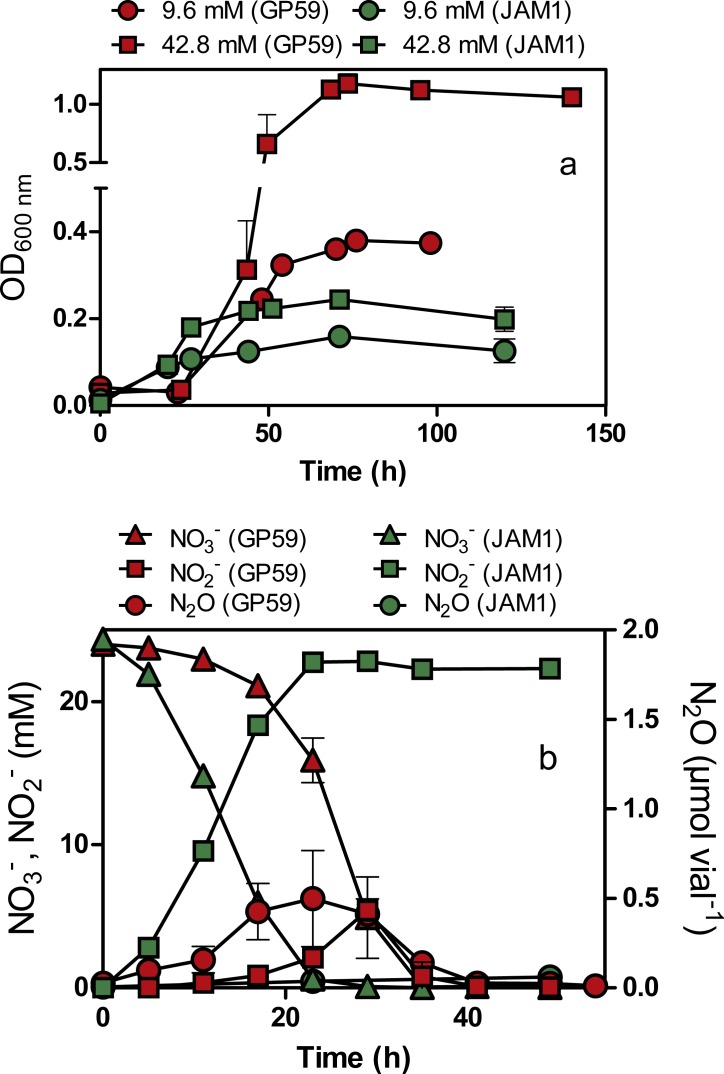
Growth, and NO\documentclass[12pt]{minimal}
\usepackage{amsmath}
\usepackage{wasysym}
\usepackage{amsfonts}
\usepackage{amssymb}
\usepackage{amsbsy}
\usepackage{upgreek}
\usepackage{mathrsfs}
\setlength{\oddsidemargin}{-69pt}
\begin{document}
}{}${}_{3}^{-}$\end{document}3−, NO\documentclass[12pt]{minimal}
\usepackage{amsmath}
\usepackage{wasysym}
\usepackage{amsfonts}
\usepackage{amssymb}
\usepackage{amsbsy}
\usepackage{upgreek}
\usepackage{mathrsfs}
\setlength{\oddsidemargin}{-69pt}
\begin{document}
}{}${}_{2}^{-}$\end{document}2− and N2O dynamics by Methylophaga nitratireducenticrescens GP59 and JAM1.(A) Growth. Strain GP59 and strain JAM1 were cultured under anoxic conditions with 9.6 or 42.8 mM NO\documentclass[12pt]{minimal}
\usepackage{amsmath}
\usepackage{wasysym}
\usepackage{amsfonts}
\usepackage{amssymb}
\usepackage{amsbsy}
\usepackage{upgreek}
\usepackage{mathrsfs}
\setlength{\oddsidemargin}{-69pt}
\begin{document}
}{}${}_{3}^{-}$\end{document}3−. (B) NO\documentclass[12pt]{minimal}
\usepackage{amsmath}
\usepackage{wasysym}
\usepackage{amsfonts}
\usepackage{amssymb}
\usepackage{amsbsy}
\usepackage{upgreek}
\usepackage{mathrsfs}
\setlength{\oddsidemargin}{-69pt}
\begin{document}
}{}${}_{3}^{-}$\end{document}3−, NO\documentclass[12pt]{minimal}
\usepackage{amsmath}
\usepackage{wasysym}
\usepackage{amsfonts}
\usepackage{amssymb}
\usepackage{amsbsy}
\usepackage{upgreek}
\usepackage{mathrsfs}
\setlength{\oddsidemargin}{-69pt}
\begin{document}
}{}${}_{2}^{-}$\end{document}2− and N2O dynamics. Strain GP59 and strain JAM1 were cultured under anoxic conditions with 21.4 mM NO\documentclass[12pt]{minimal}
\usepackage{amsmath}
\usepackage{wasysym}
\usepackage{amsfonts}
\usepackage{amssymb}
\usepackage{amsbsy}
\usepackage{upgreek}
\usepackage{mathrsfs}
\setlength{\oddsidemargin}{-69pt}
\begin{document}
}{}${}_{3}^{-}$\end{document}3−, and NO\documentclass[12pt]{minimal}
\usepackage{amsmath}
\usepackage{wasysym}
\usepackage{amsfonts}
\usepackage{amssymb}
\usepackage{amsbsy}
\usepackage{upgreek}
\usepackage{mathrsfs}
\setlength{\oddsidemargin}{-69pt}
\begin{document}
}{}${}_{3}^{-}$\end{document}3−, NO\documentclass[12pt]{minimal}
\usepackage{amsmath}
\usepackage{wasysym}
\usepackage{amsfonts}
\usepackage{amssymb}
\usepackage{amsbsy}
\usepackage{upgreek}
\usepackage{mathrsfs}
\setlength{\oddsidemargin}{-69pt}
\begin{document}
}{}${}_{2}^{-}$\end{document}2− and N2O were measured over different time intervals. Each point is the average with standard deviation of triplicate cultures for (A), and of duplicate cultures for (B).